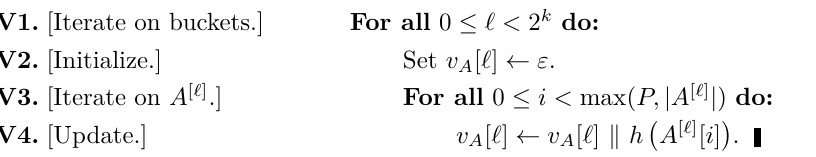
Algorithm V ( Initialise vectors for preliminary test ). Given a list A dispatched into 2 k buckets, create the table v A